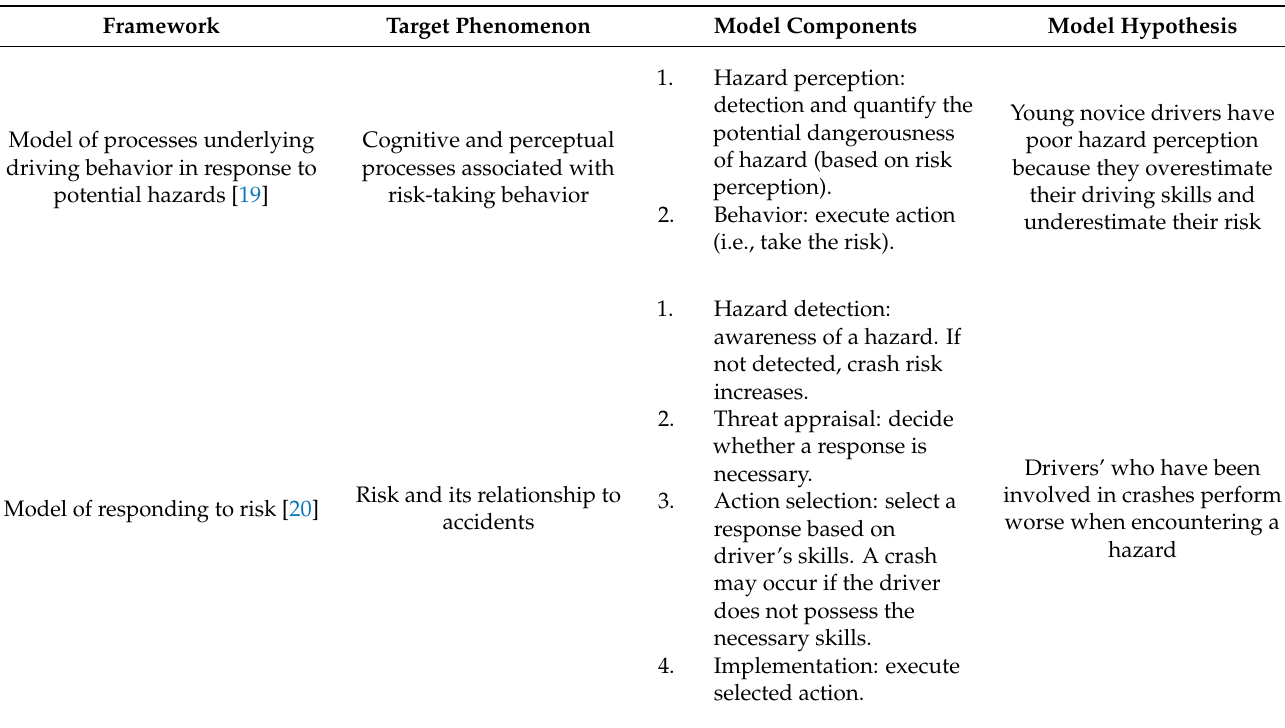
Table A1. Existing frameworks explaining hazard processing.